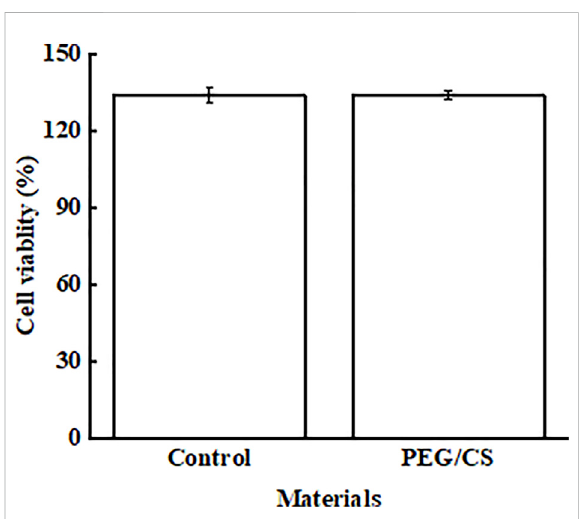
FIGURE 4 Viability of L929 cells treated with PBS (control) and PEG/CS, as determined with the Cell Counting Kit-8